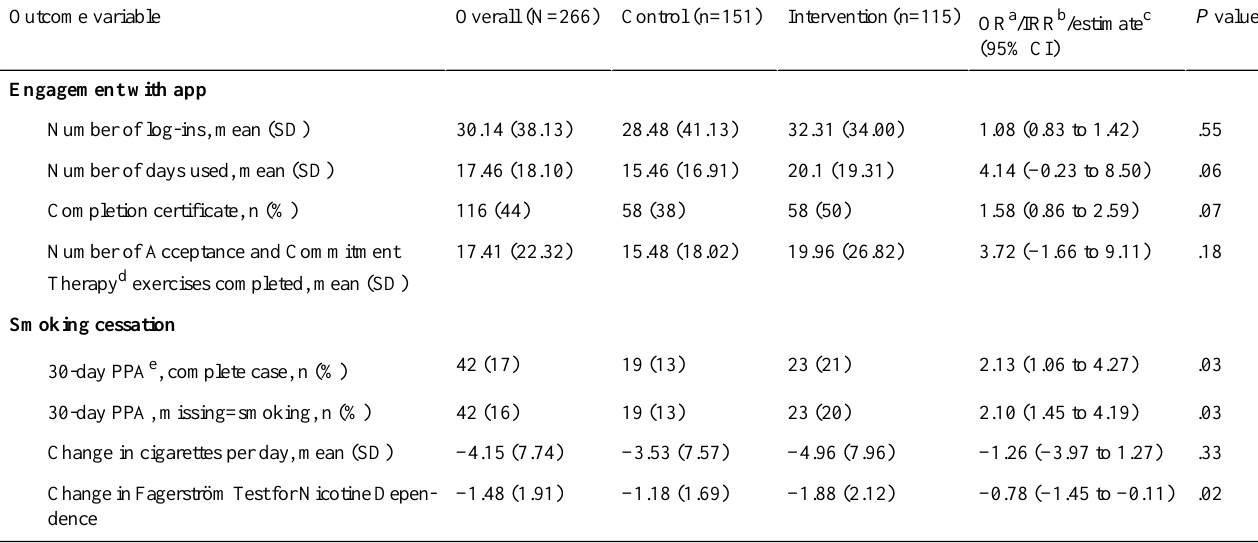
Table 3. Smoking cessation and engagement with cessation program at 2-month follow-up with the Modified-Intention-to-Treat analysis. Results are adjusted for 2 stratification factors (heavy smoking and education). Cessation results are adjusted for baseline self-efficacy.